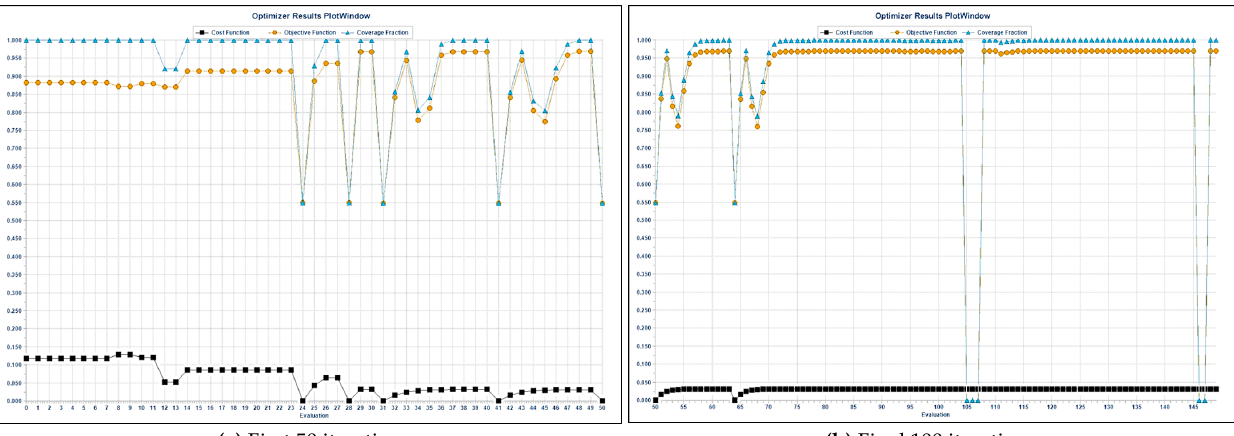
(b) Final 100 iterations: semi-major axis Figure 17. Semi-major axis optimization process for the first 50 and concluding iterations. In the figures above, the variations started with initial iterations adjusting to the best inclination possible for the constellation for a better coverage, which stabilized well in the